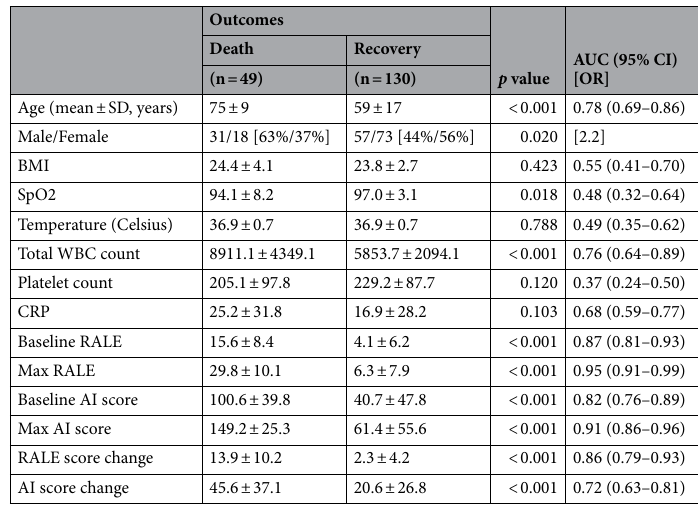
Table 3. Summary of assessed variables for prediction of death versus recovery from COVID-19 pneumonia in patients from Site B. Maximum RALE and AI scores were the strongest predictors of final patient outcome. SD standard deviation, BMI body mass index, SpO 2 peripheral oxygen saturation, CRP c-reactive protein, max maximum, AUC area under the curve, CI confidence interval, OR odd’s ratio, % percentage. Numbers in square parenthesis represent odd’s ratios (R2-14).